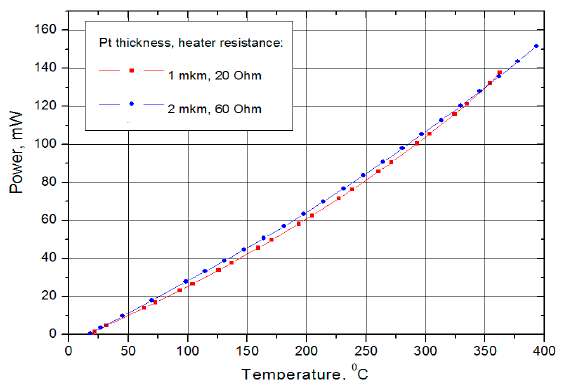
Figure 6. Platinum microheater power consumption as a function of working temperature. The resistance of heaters with two different thicknesses is shown in the plot .